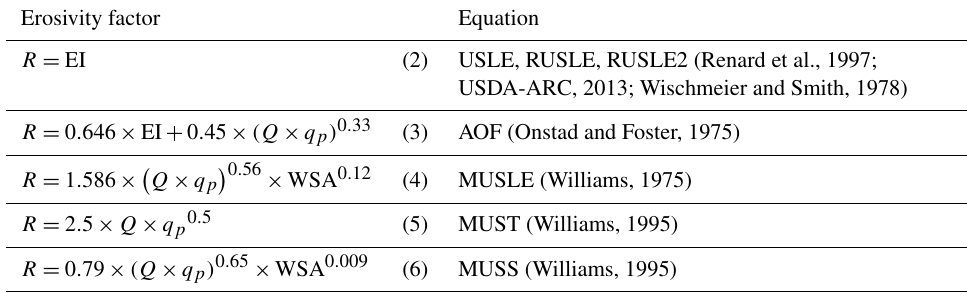
Table 1. Equations for calculating the erosivity factor in each water erosion equation available in EPIC. Erosivity factor Equation USLE, RUSLE, RUSLE2 (Renard et al., 1997; USDA-ARC, 2013; Wischmeier and Smith,